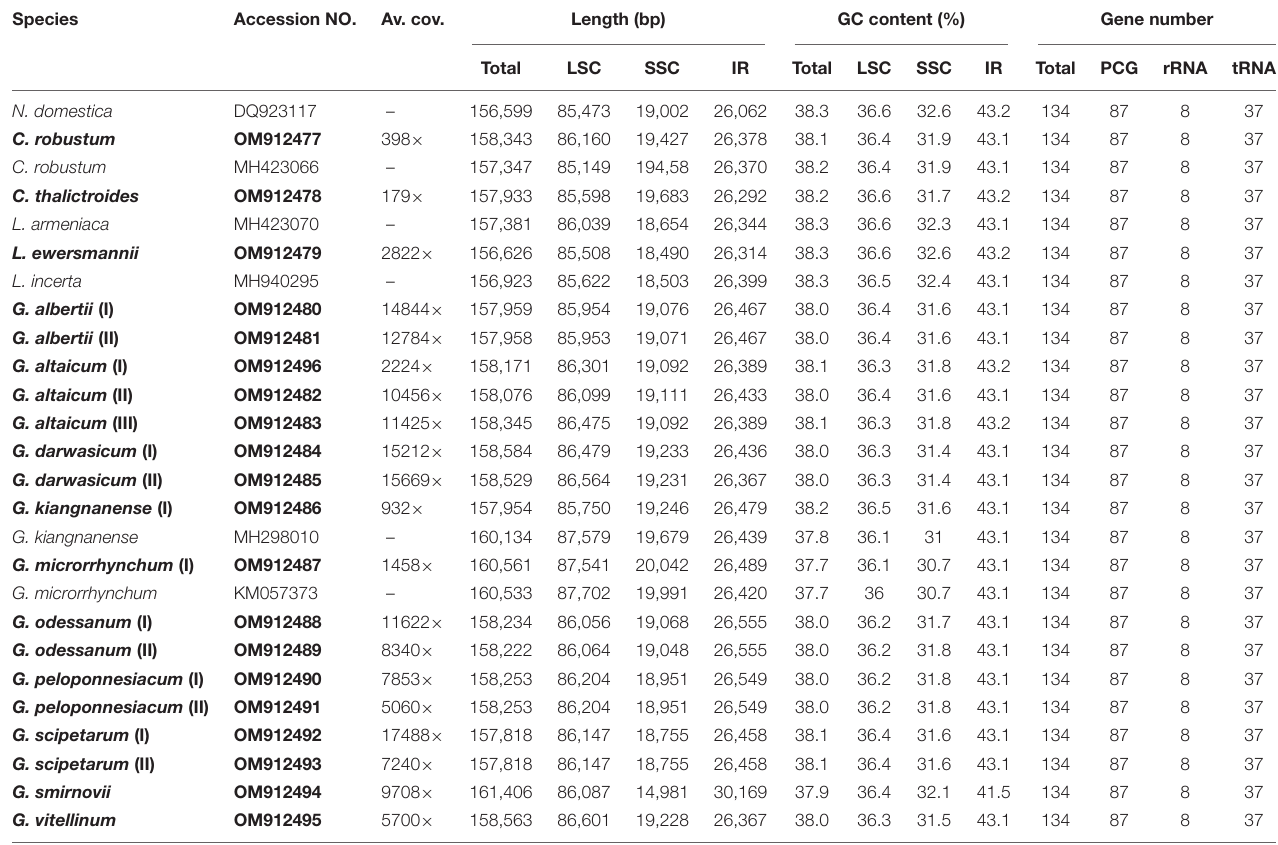
TABLE 2 | Basic characteristics of the 26 plastomes of Nandinoideae analyzed in this study. Species Accession NO. Av.